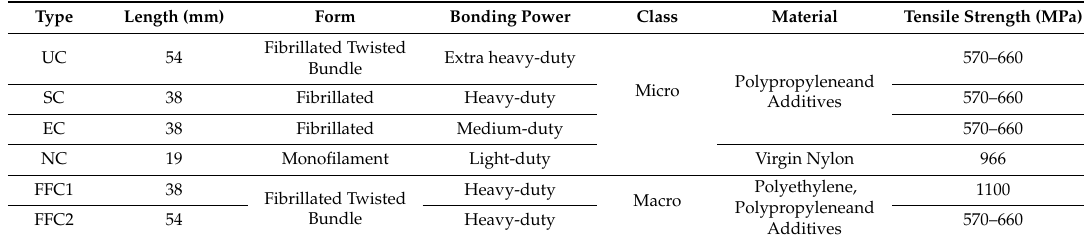
Figure 1. All the fibers used in this study which consists of the ( a ) Ultra-Net, ( b ) Super-Net, ( c ) Econo- Figure1. Allthefibersusedinthisstudywhichconsistsofthe( a )Ultra-Net, ( b )Super-Net, ( c )Econo-Net, Net, ( d ) Nylo-Mono microfibers and the ( e ) Ferro macrofibers. ( d ) Nylo-Mono microfibers and the ( e ) Ferro macrofibers. Table 1. Specifications of fibers as listed in the FORTA fibers technical data sheet. (UC: Ultra-Net; SC: Super-Net, EC: Econo-Net; NC: Nylo-Mono; FFC: